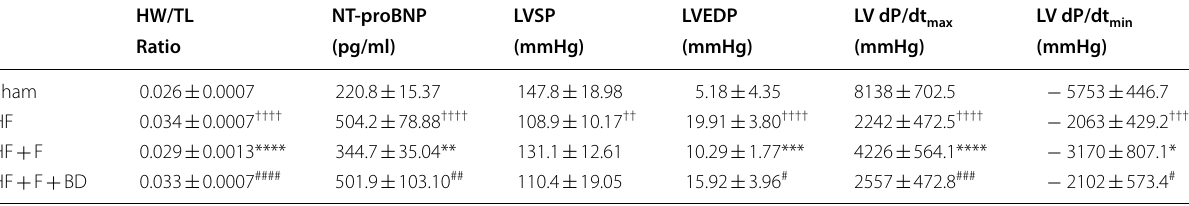
HW/TL, heart weight/tibial length; NT-proBNP, NT-proBNP concentration in serum; LVSP, LV systolic pressure; LVEDP, LV end-diastolic pressure; LV dp/dt max , LV dp/dt min , maximal rate of pressure rise and decline (dP/dt max and dP/dt min ); † P HF group vs sham group; *P HF P<0.05; ††, ** , ## : P <0.01; *** , ### : P<0.005; ††††, **** , #### : P